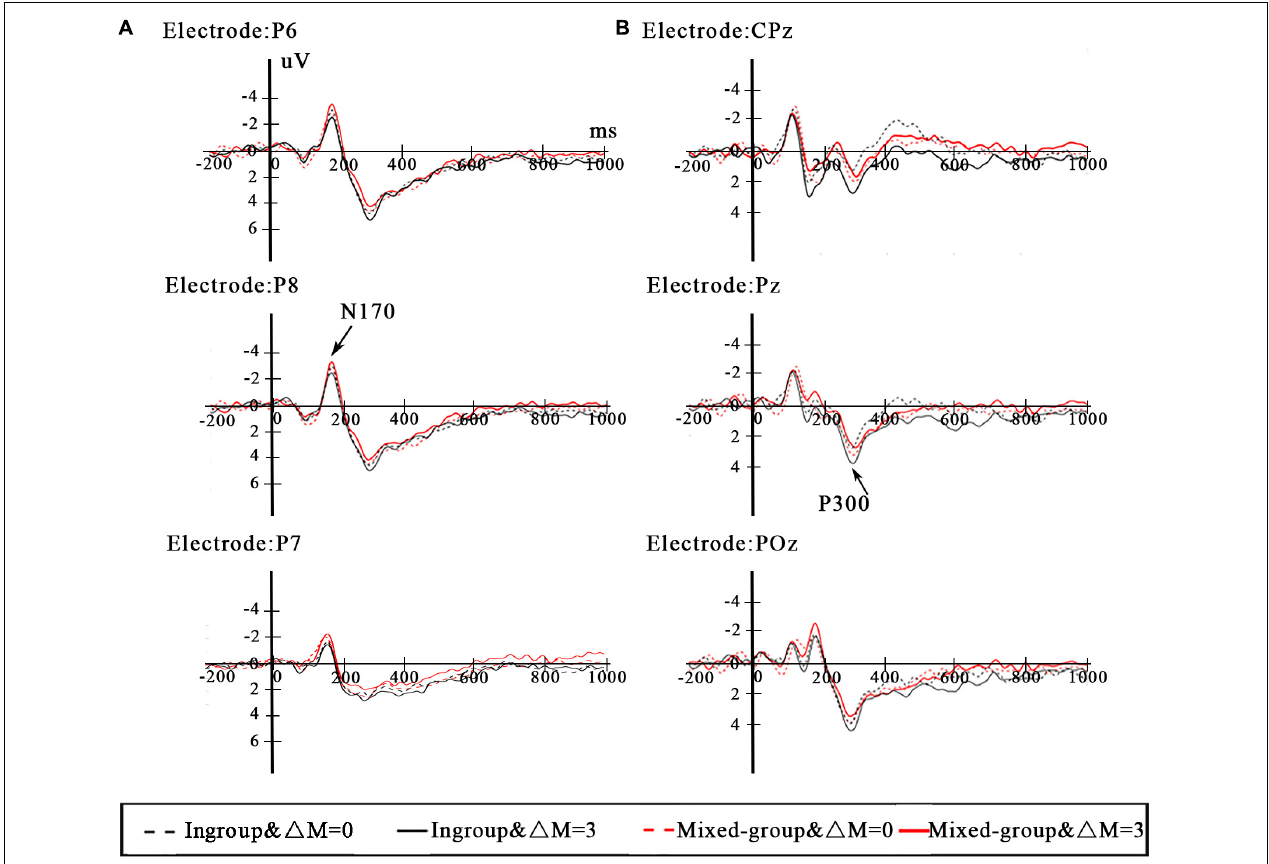
FIGURE 3 | (A) ERP waveforms from posterior electrodes P6, P7, and P8 for N170. (B) ERP waveforms from parietal electrodes CPz, Pz, and POz for